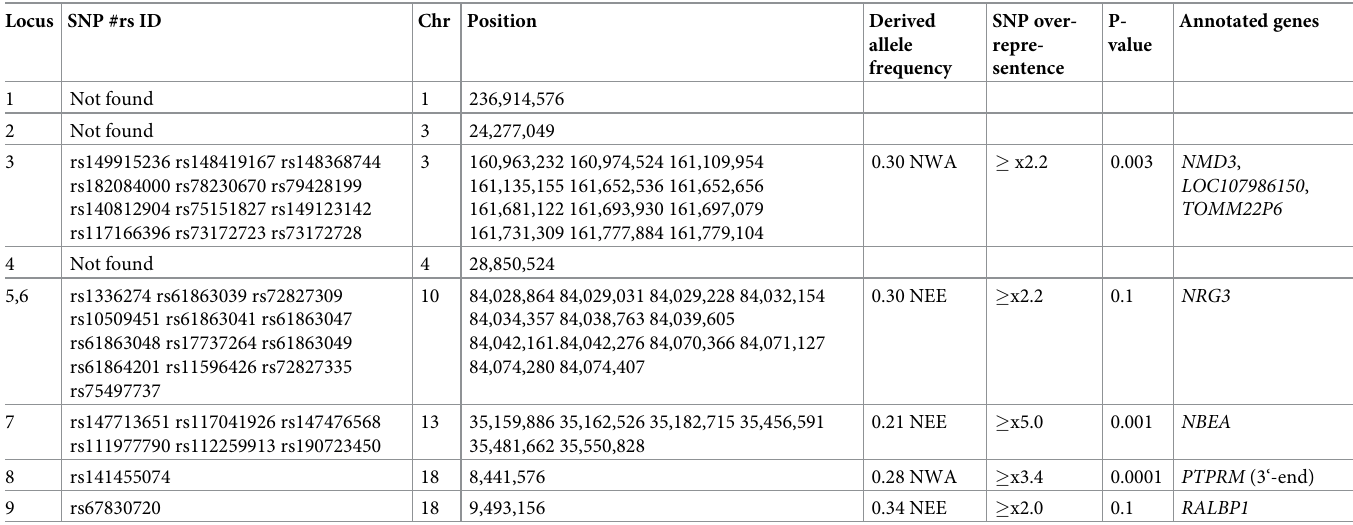
Table 3. SNPs of sequenced genomes within 9 loci described in Table 1 � .